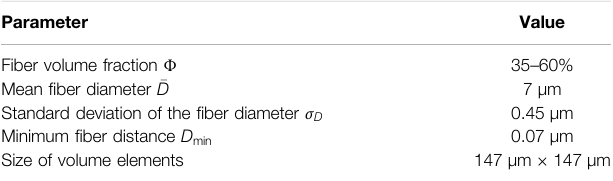
TABLE 1| Con fi guration parametersofthe SVEs; for each con fi guration, 10 SVEs are generated. Parameter